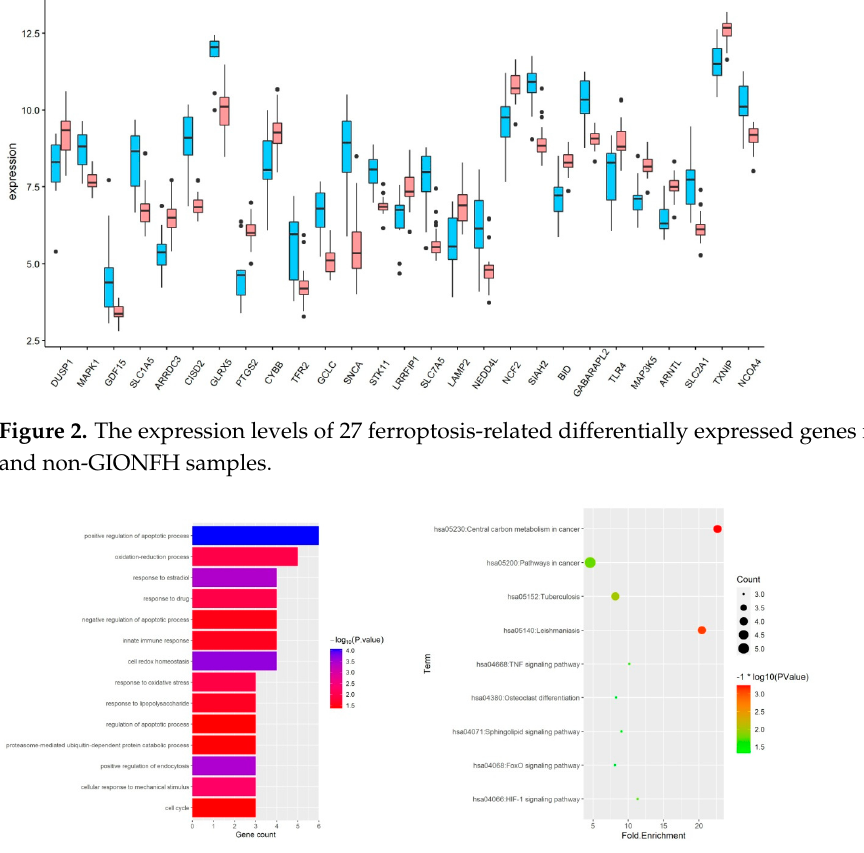
Figure 3. GO, and KEGG functional enrichment analysis of 27 ferroptosis-related differentially expressed genes in GIONFH and non-GIONFH samples. ( a ) GO functional enrichment analysis of 27 ferroptosis-related differentially expressed genes in GIONFH and non-GIONFH samples. ( b ) KEGG pathway analysis of 27 ferroptosis-related differentially expressed genes in GIONFH and non-GIONFH samples. Table 1. GO functional enrichment analysis of 27 ferroptosis-related differentially expressed genes in GIONFH and non-GIONFH samples.